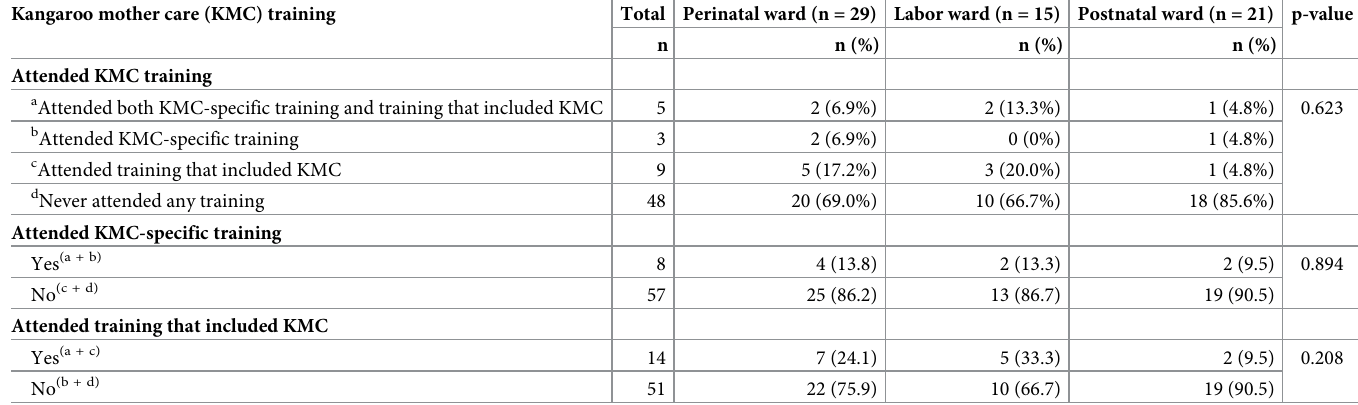
Table 2. Percentages of nursing staff who had attended kangaroo mother care-related training. Kangaroo mother care (KMC)